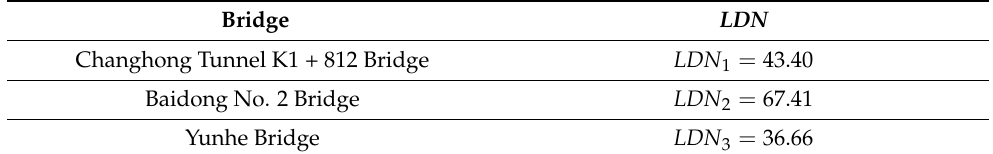
Table 6. LDN of Changhong Tunnel K1 + 812 Bridge, Baidong No. 2 Bridge, and Yunhe Bridge. Bridge